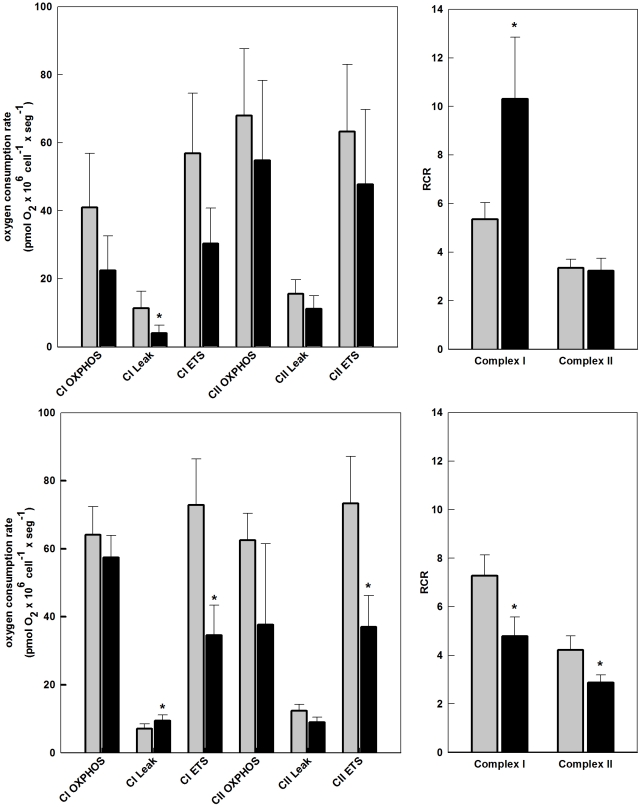
High-resolution respirometry reveals mitochondrial dysfunction in permeabilized Neuro 2a cells infected with SinV.Oxygen consumption rates were measured on digitonin-permeabilized Neuro 2a cells in mitochondrial medium MiR05. CIOXPHOS oxygen consumption rates after addition of 5 mM pyruvate +5 mM malate +2.5 mM ADP; CILeak oxygen consumption rates after addition of olygomycin, supported by CI substrates; CIETS oxygen consumption rates after FCCP addition, driven by CI substrates; CIIOXPHOS oxygen consumption rates after addition of rotenone, 10 mM succinate +2.5 mM ADP; CIILeak oxygen consumption rates after addition of olygomycin, supported by CII substrate; CIIETS oxygen consumption rates after FCCP addition, driven by CII substrate. Respiratory control ratio (RCR) represents CIETS/CILeak CIIETS/CIILeak for complexes I and II, respectively. Mock-infected (gray bars) and SinV-infected (black bars) after 15 h (a,b) and 24 h (c,d). Values represent mean ± SEM; N = 10 for 24 h and N = 7 for 15 h, *P<0.05 compared to mock-infected cells.